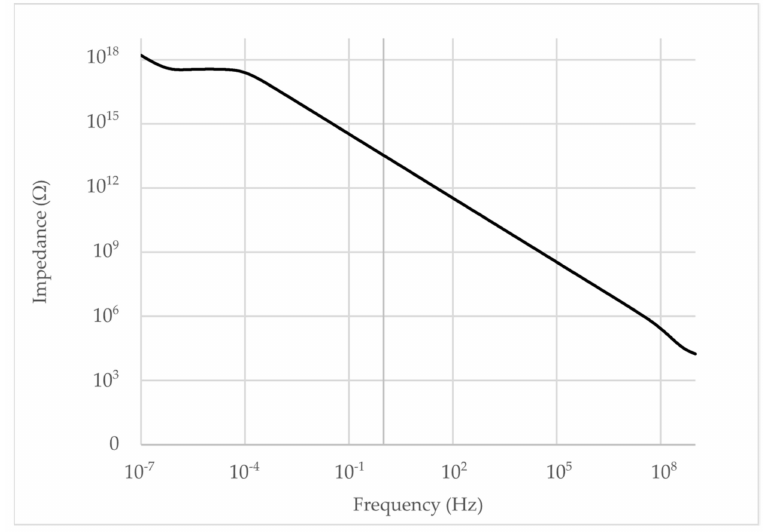
Figure 11. Input impedance of the proposed